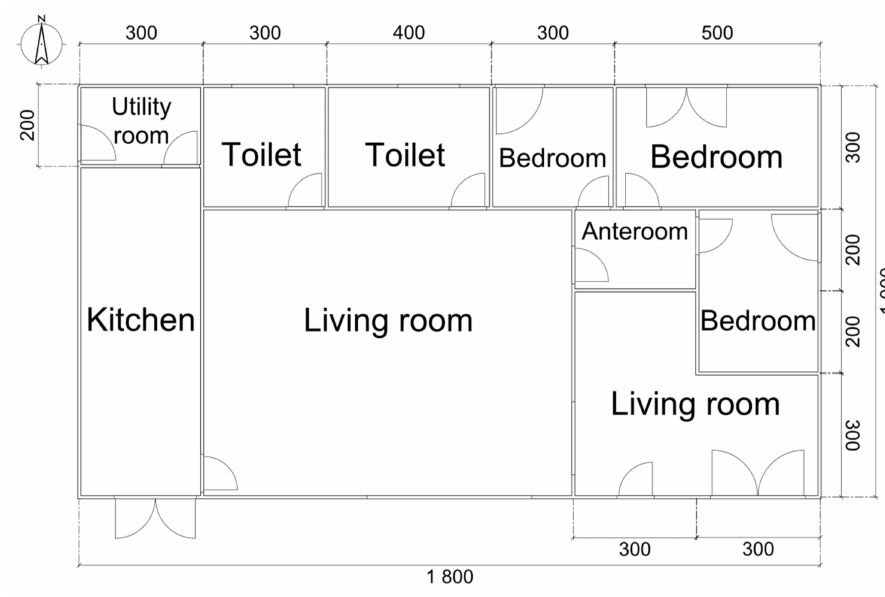
Figure 1. Plan views of the benchmark single detached house (dimensions in cm).